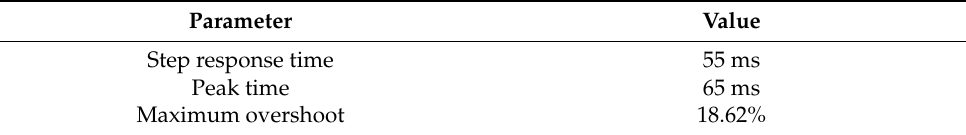
Table 2. Important data relating to results.